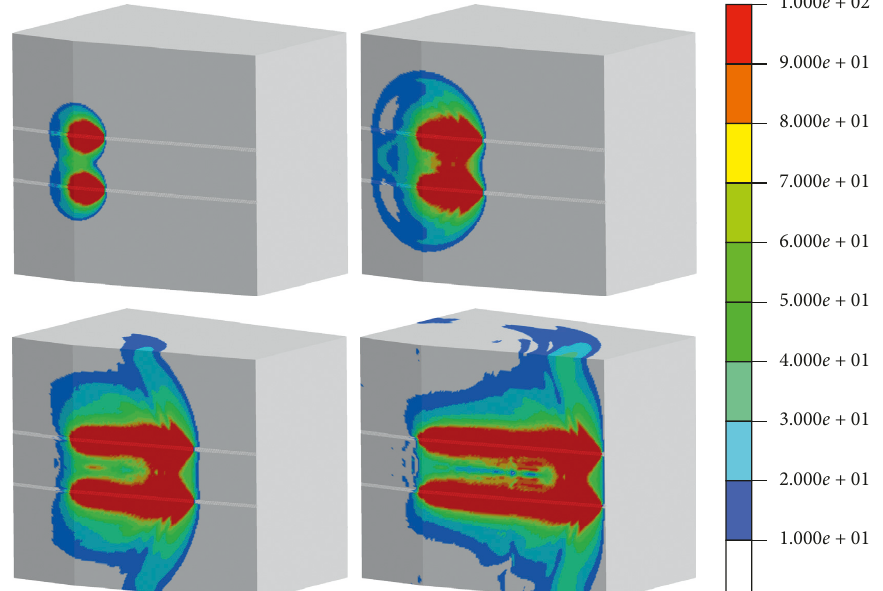
Figure 7: Pressure distribution over rock area for selected time points (MPa). (a) t